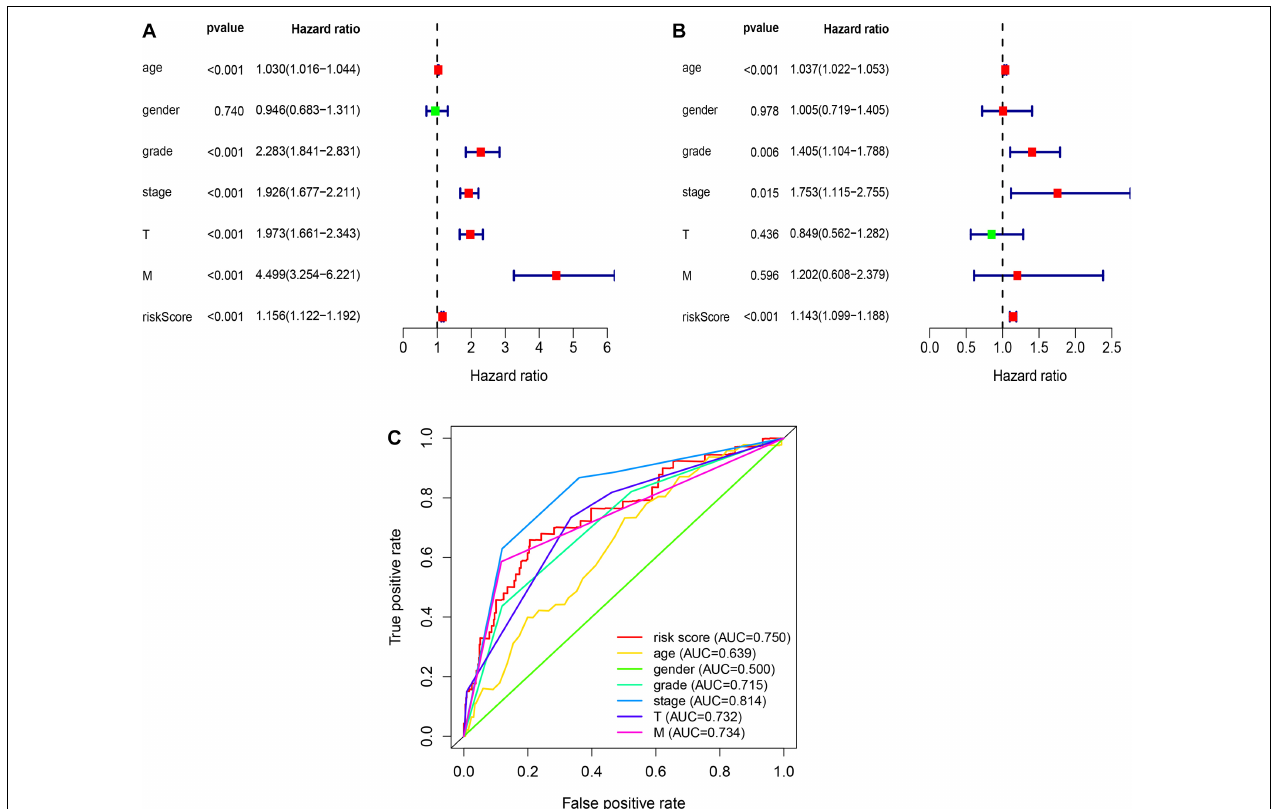
FIGURE 3 | The independent prediction of glycolysis-related lncRNAs risk signature. (A) Univariate analysis reveal that glycolysis-related lncRNAs prognostic risk scores ( P < 0.001) and other clinical features were significantly correlated with survival time except gender ( P = 0.740). (B) Multivariate analysis shows that age ( P < 0.001), AJCC stage ( P < 0.05), grade ( P < 0.05), and glycolysis-related lncRNAs prognostic risk score ( P < 0.001) were independent prognostic indicators. (C) Multi-parameter ROC curve analysis shows the different AUC values among the clinicopathological